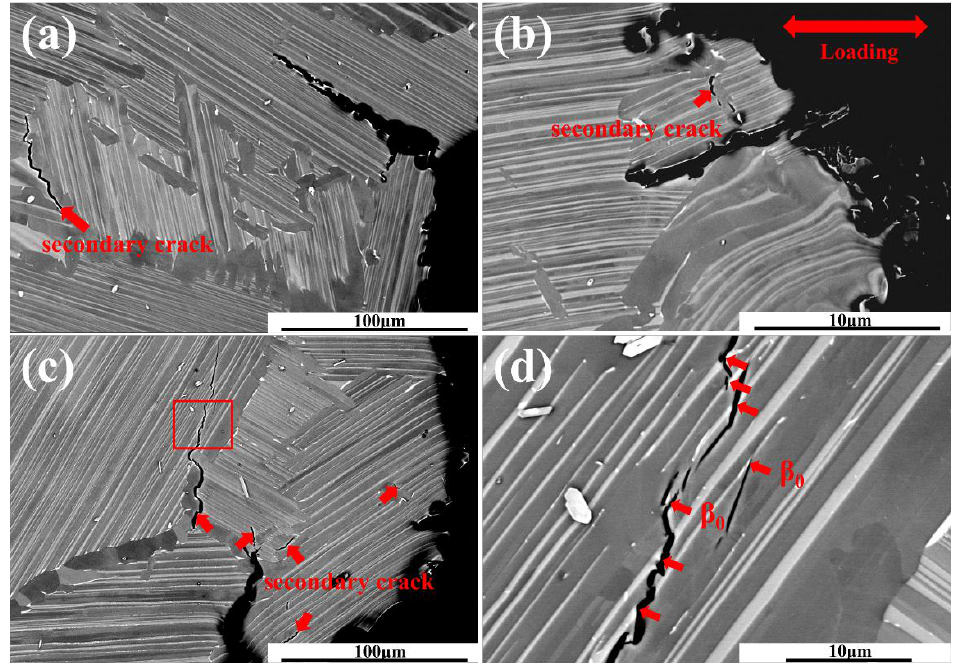
Figure 7. BSE-SEM micrographs present the near main crack after the 800 °C tensile test. ( a ) un- treated P-HIPed TNM; ( b ) exposed at 850 °C/5h/FC; ( c , d )exposed at 1050 °C/2 h/FC. P-HIPed TNM; ( b ) exposed at 850 ◦ C/5h/FC; ( c , d )exposed at 1050 ◦ C/2